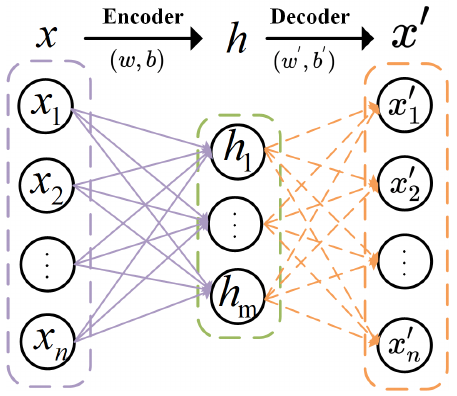
Figure 1. The structure of